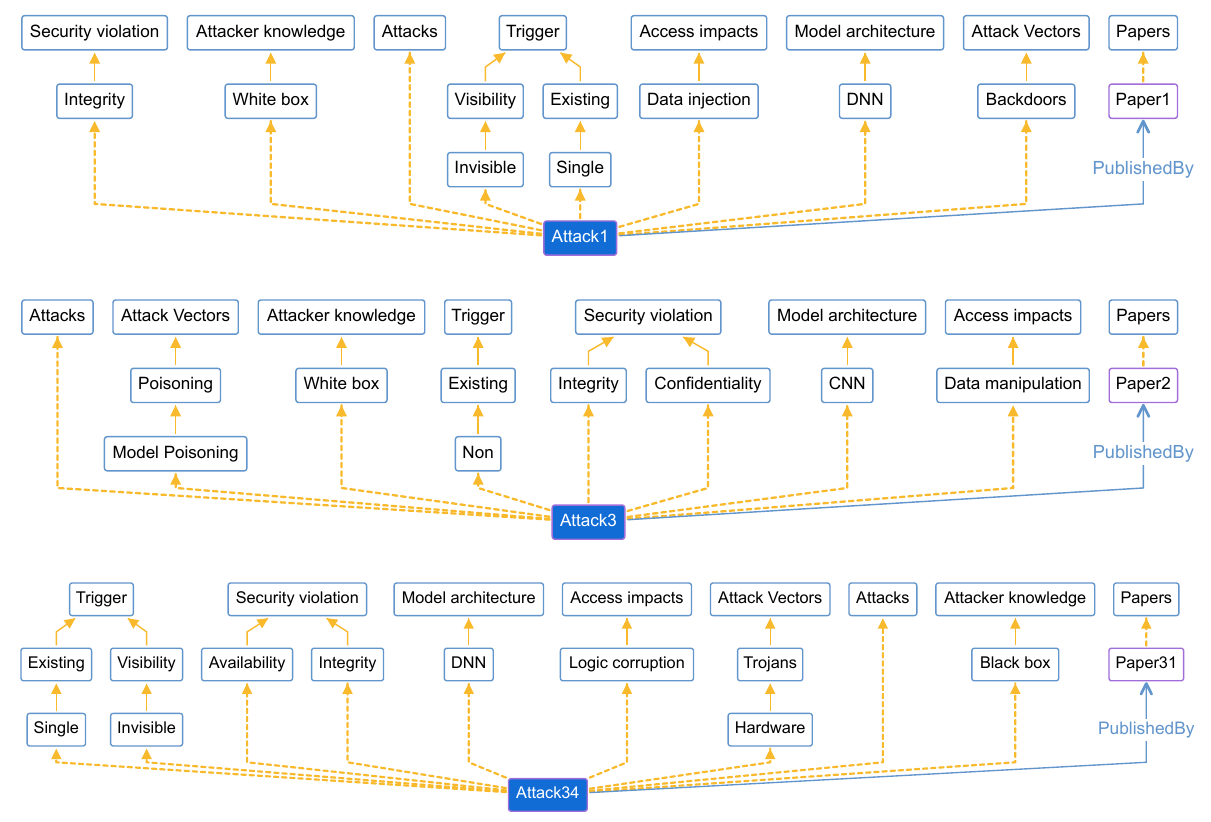
Figure 8. Three individuals (i.e., attacks), Attack1, Attack3, and Attack34, as instances of DNNPAO classes and